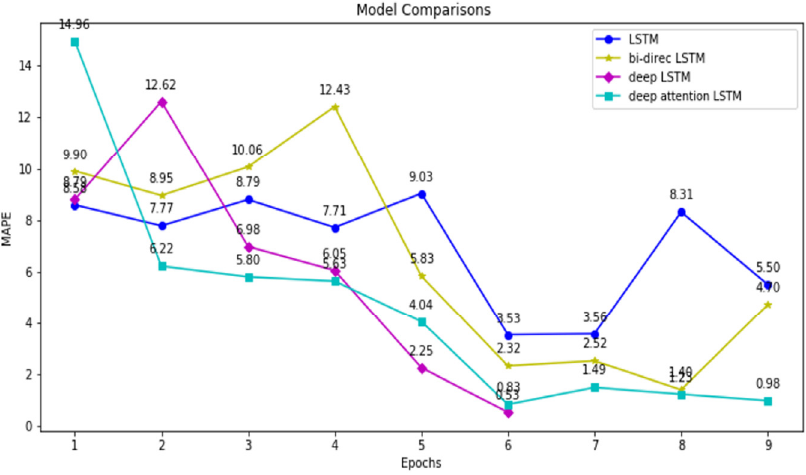
Figure 17. MAPE for different models by various epochs.